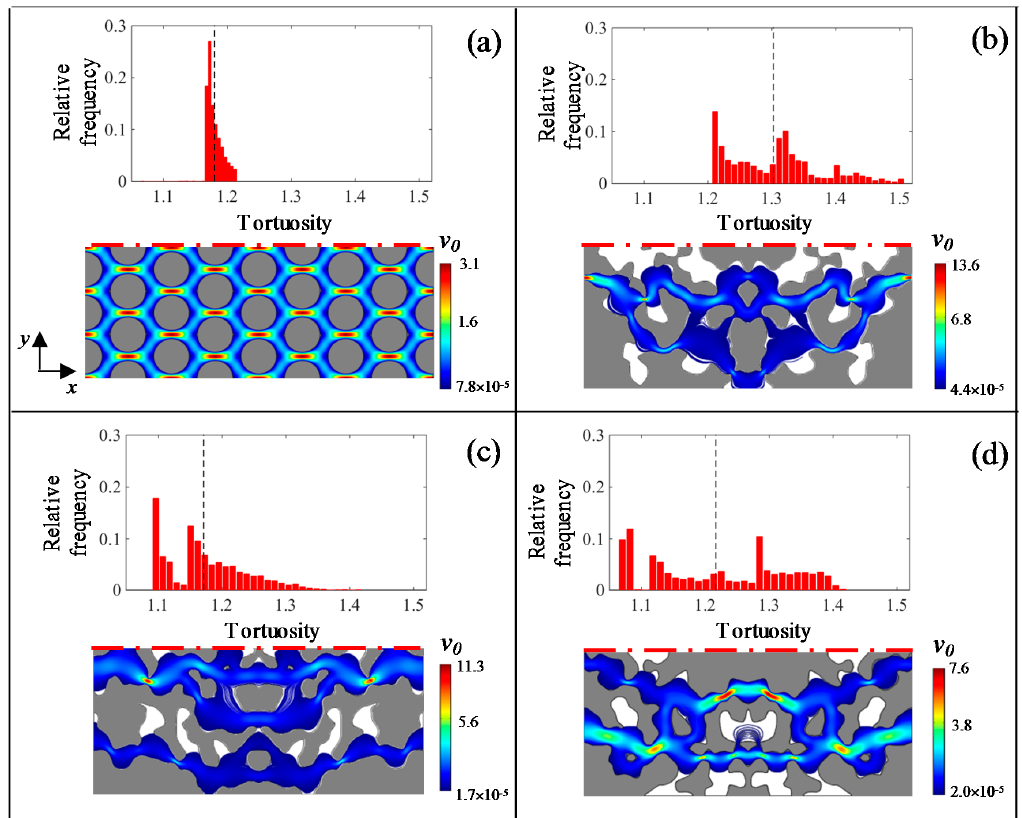
Figure 3. Histogram of tortuosity, τ , and particle trajectories through the elementary cells (color scale expressed in terms of local normalized velocity v 0 = | v | / | v | , | v | being the norm of the velocity vector v and | v | its mean) for ( a ) HDa, ( b ) E1, ( c ) E4, and ( d ) E8. Vertical dashed lines correspond to mean tortuosity. Horizontal dashed-dotted lines indicate the axes of symmetry of the systems.